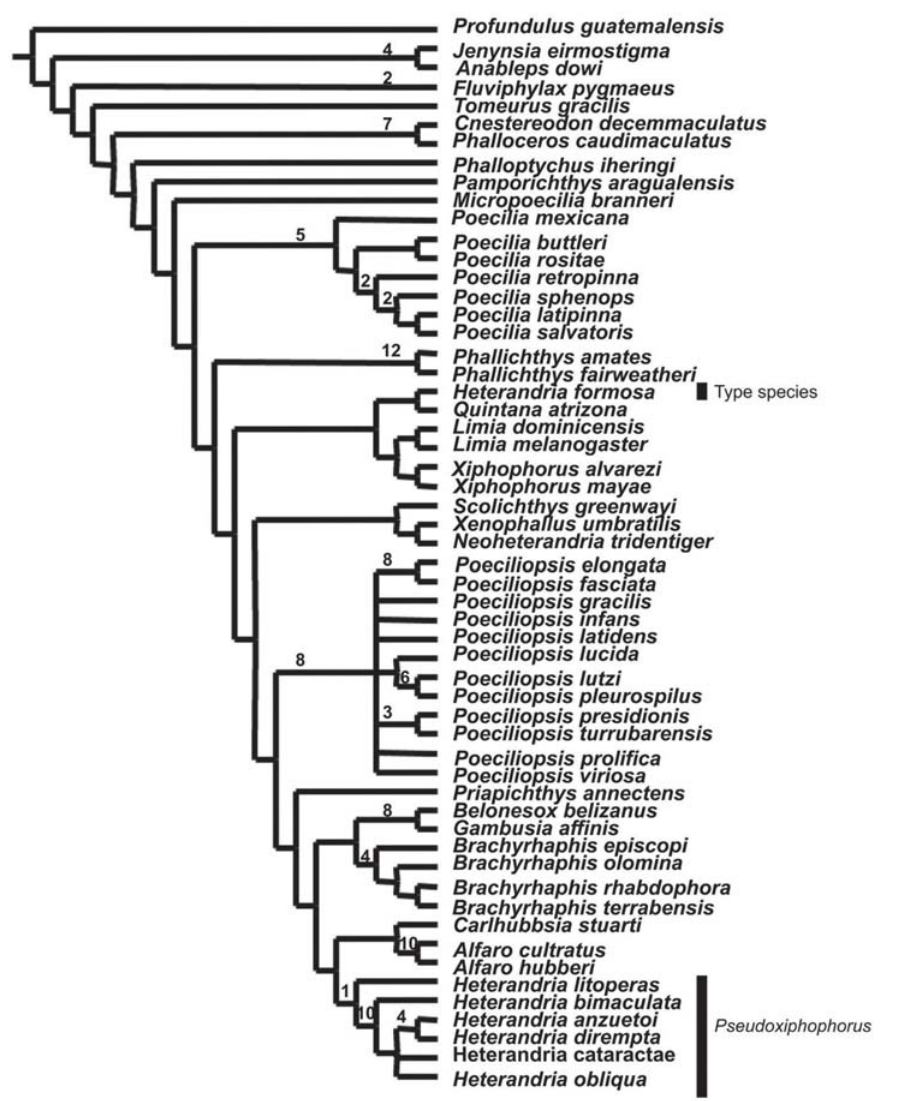
Fig. 1. Strict consensus tree of twelve MP trees with multistate characters analyzed as unordered. Each MP tree of 1,430 steps, CI = 0.20, RI = 0.48, RC = 0.10. Numbers indicate Bremer